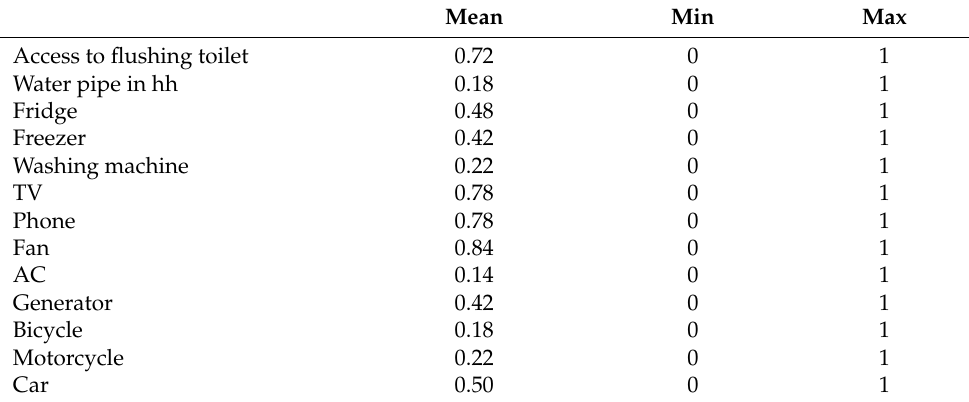
Table A2. Wealth characteristics of surveyed children [13].